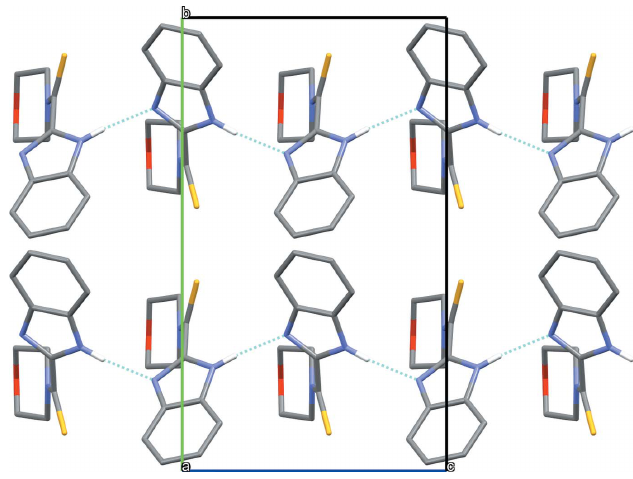
Figure 2 A view of the crystal packing of the title compound along the a axis. Intermolecular N—H (cid:3)(cid:3)(cid:3) N hydrogen bonds are indicated by blue dotted lines. Only the major component of the disordered morpholide ring is shown.